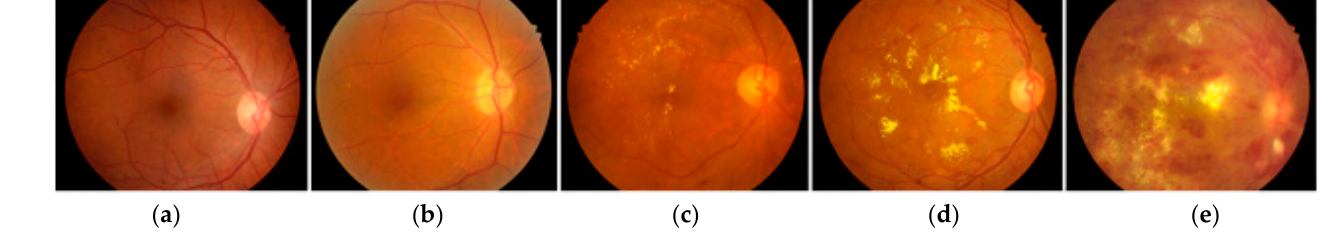
Figure 1 . Retina images. ( a ) No DR and DME, ( b ) mild DR and DME, ( c ) moderate DR and DME, ( d ) severe DR and DME, and ( e ) non-PDR.